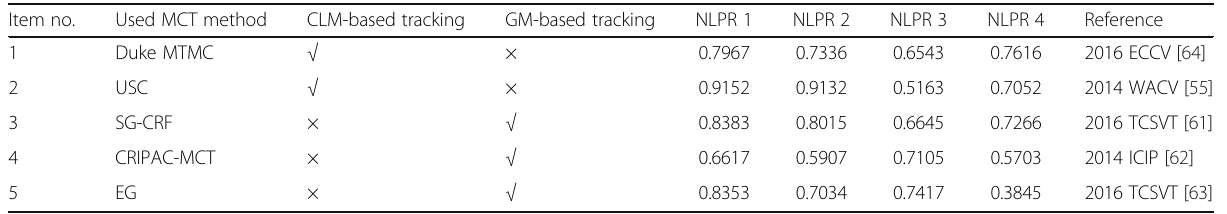
Symbols √ and × mean whether CLM/GM based tracking is used or